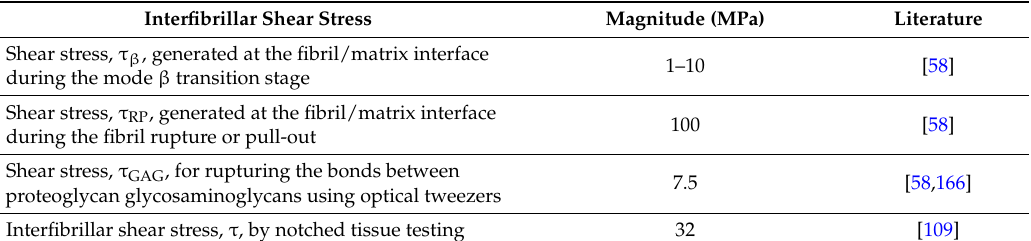
Table 4. Estimates of interfibrillar shear